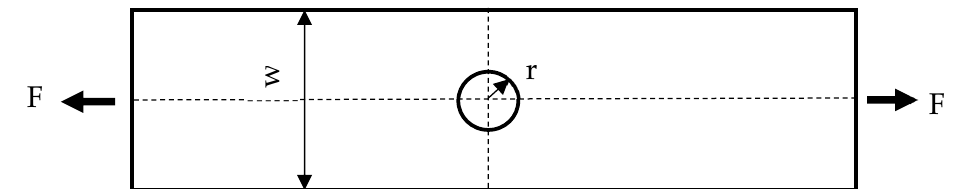
Figure 4. Center hole test specimen with 2 mm thickness (W = 24 mm, r = 1.5, 3, or 4.5 mm).